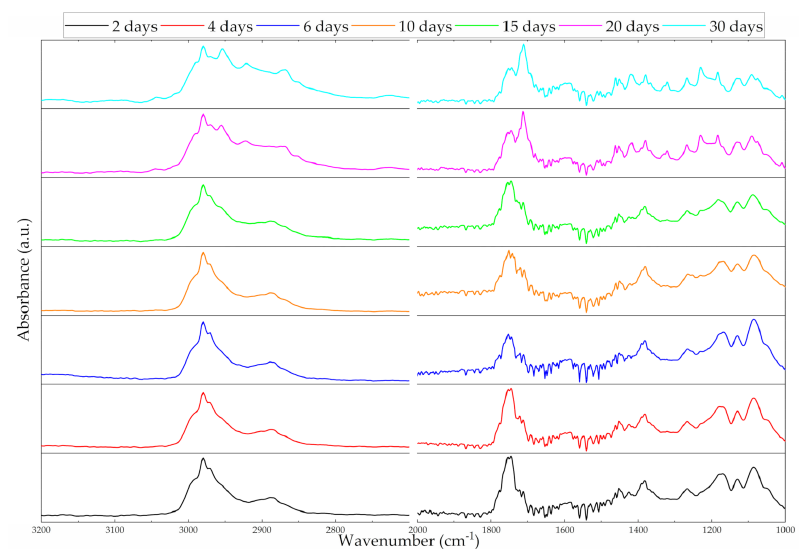
Figure 5. ATR-FTIR spectra of PLGA/IBUP coatings during biologically simulated dynamic